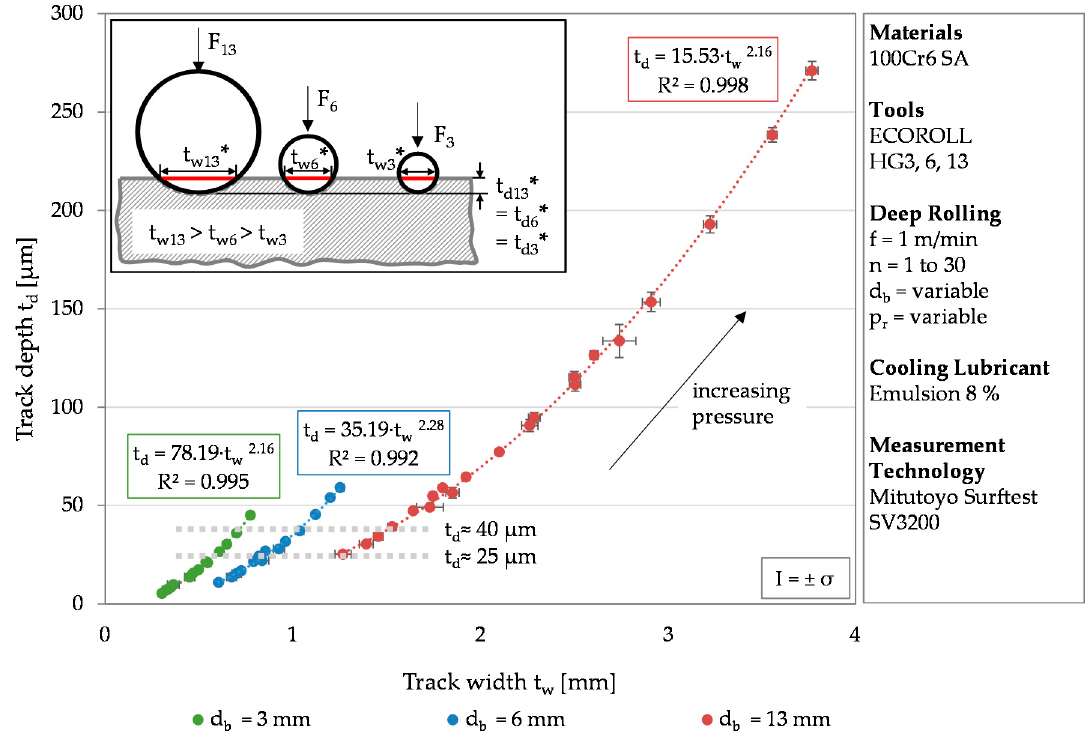
Figure 4. Correlation between the track depth and the track width as a function of the deep rolling pressure and the number of rollovers at different tool diameters.